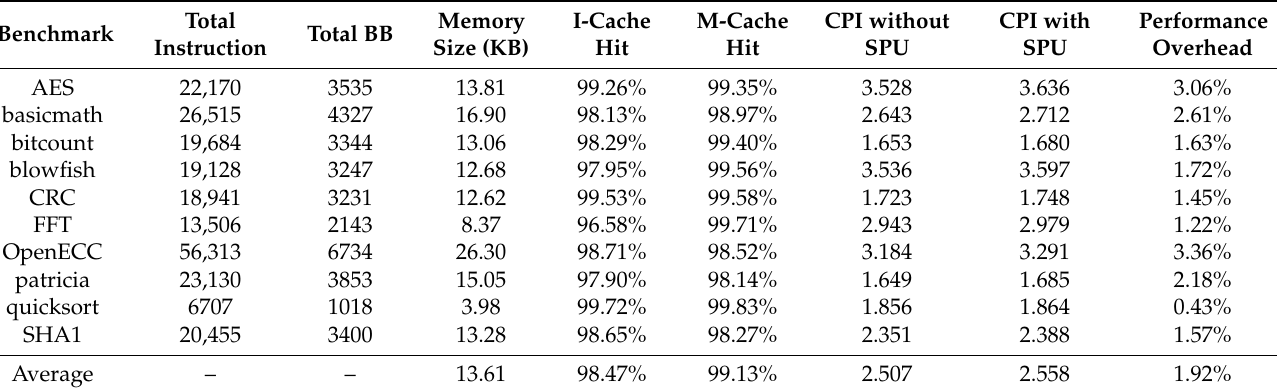
Table 2. Performance overhead of the CPU–SPU collaborative SoC (8-KB I-Cache, 8-KB D-Cache, and 8-KB M-Cache).